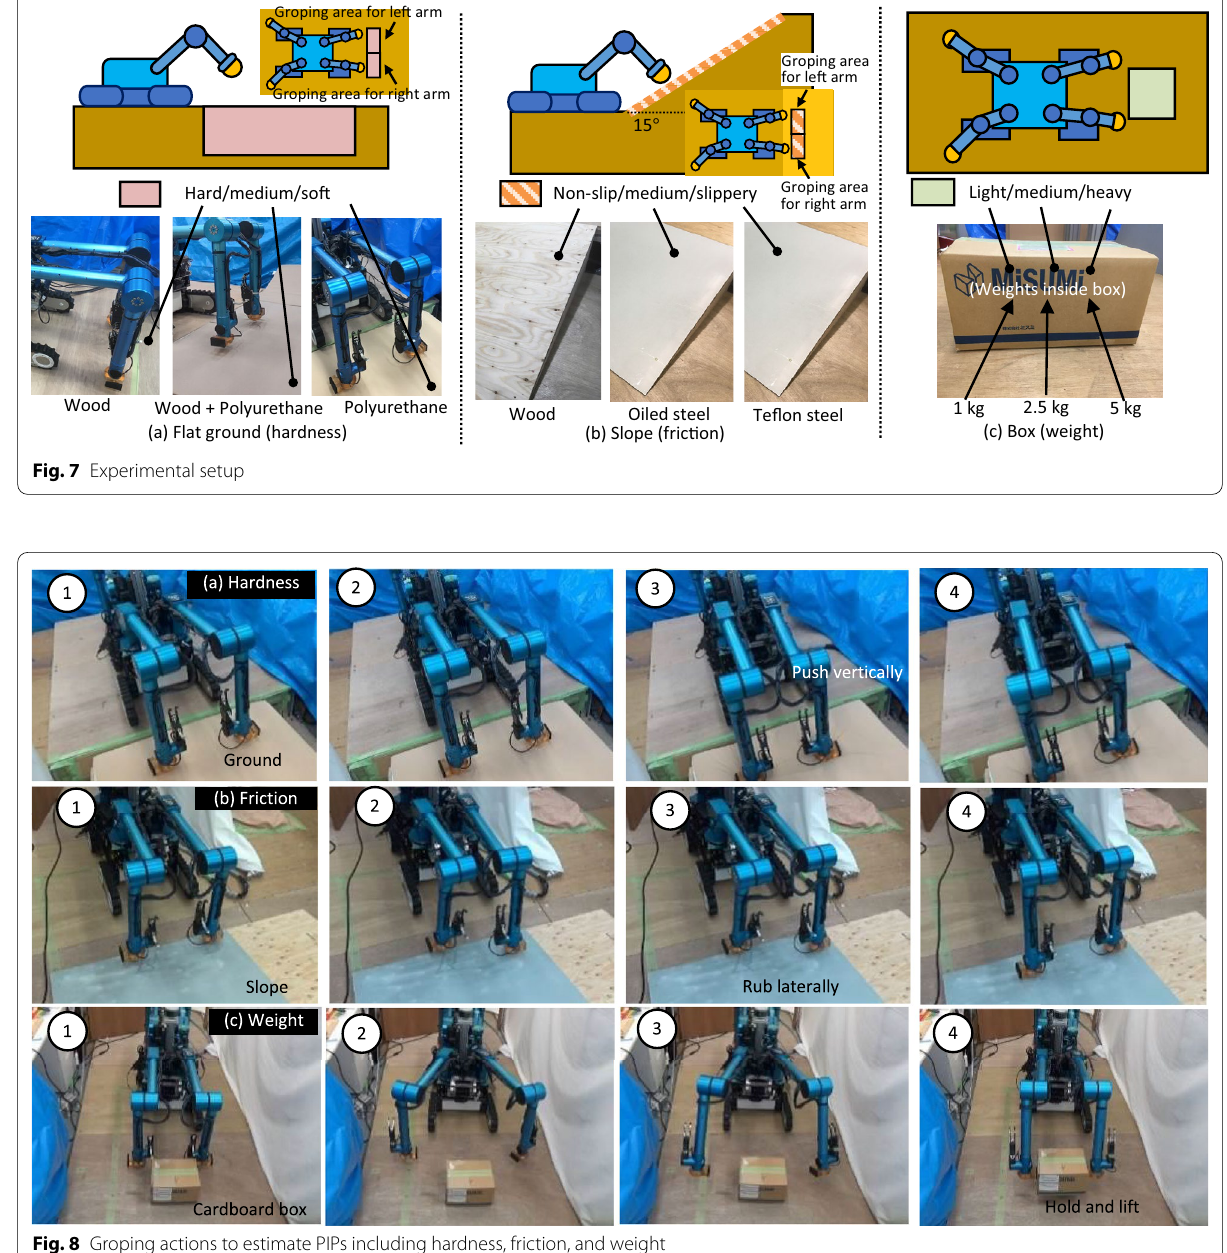
Fig. 8 Groping actions to estimate PIPs including hardness, friction, and